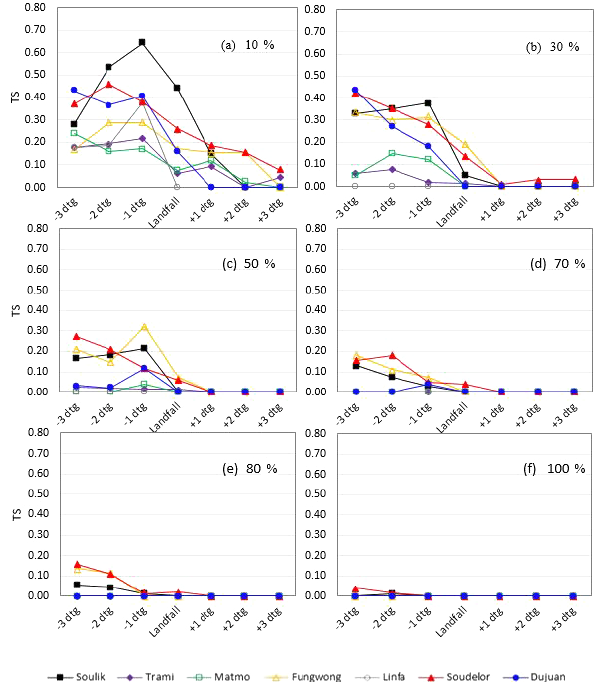
Figure 8. Comparisons of TS performance with a 25 to 48h lead time considering various probability thresholds without a data as- similation